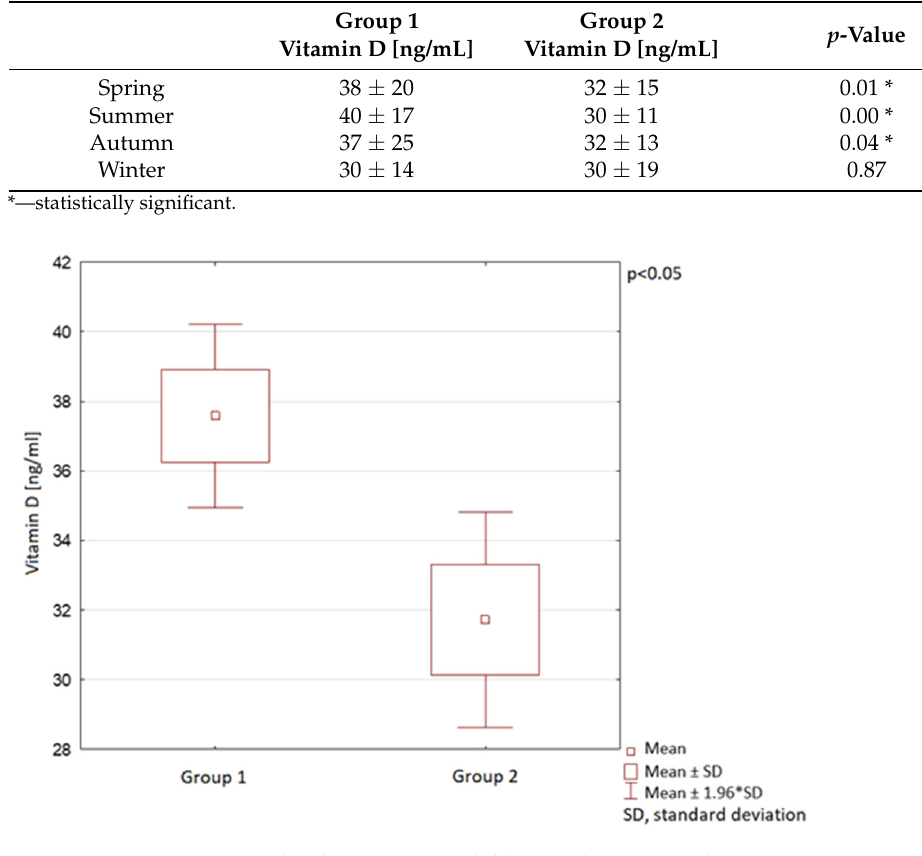
Figure 8. Vitamin D serum levels in autumn in children in the compared groups.